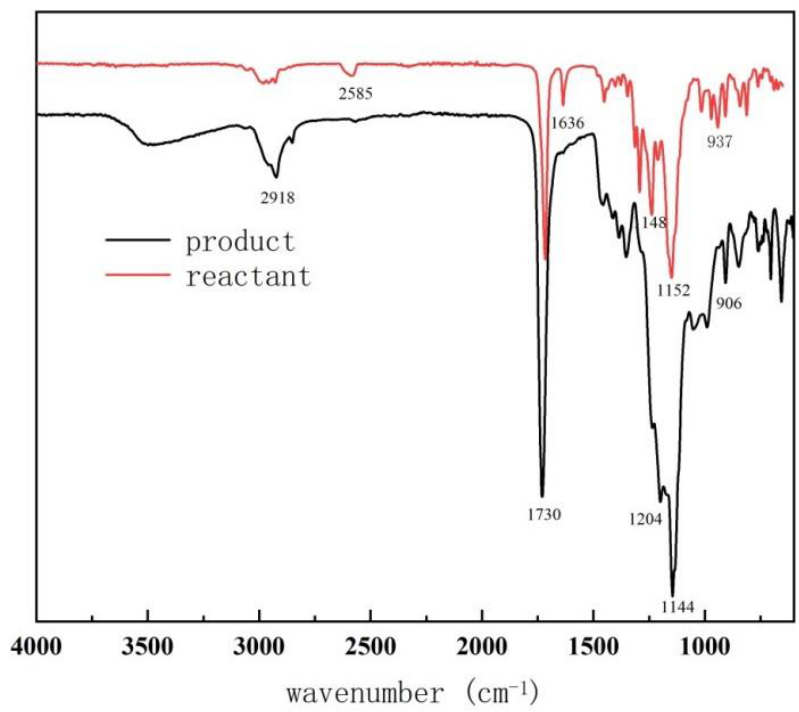
Figure 3. FT-IR spectra of the reactants (mixture of PFDA, GMA and PETMP) and product (fluori- nated epoxy).